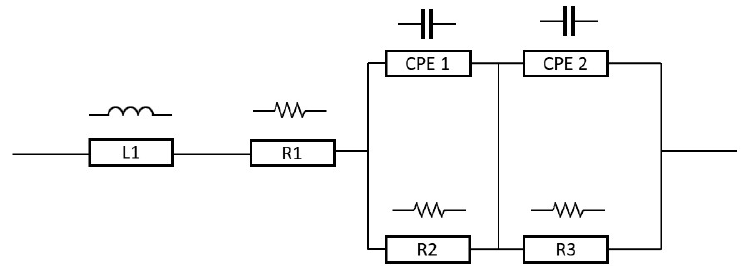
Figure 1. Equivalent EIS circuit model.